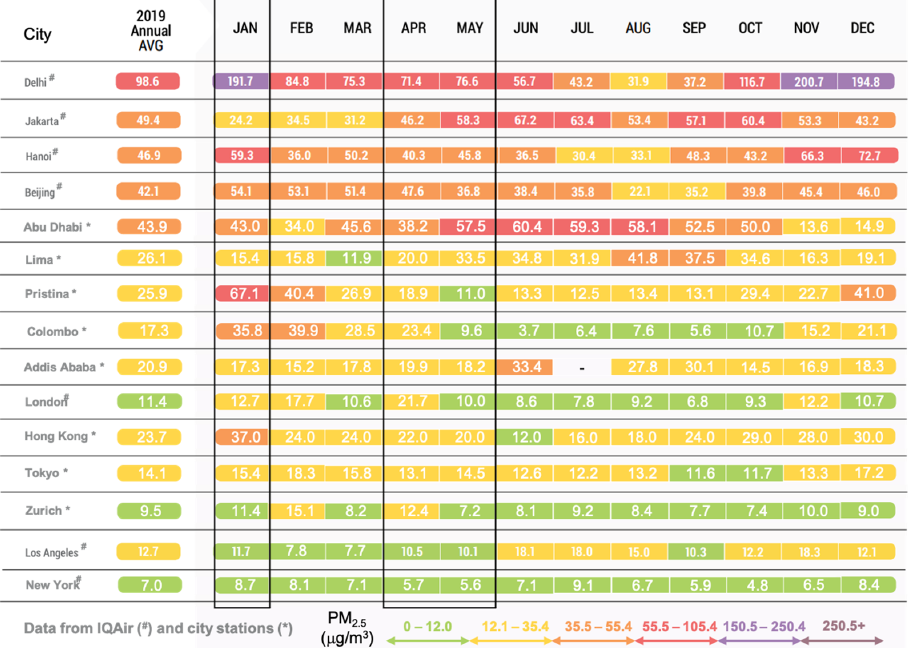
2.5 for 15 selected